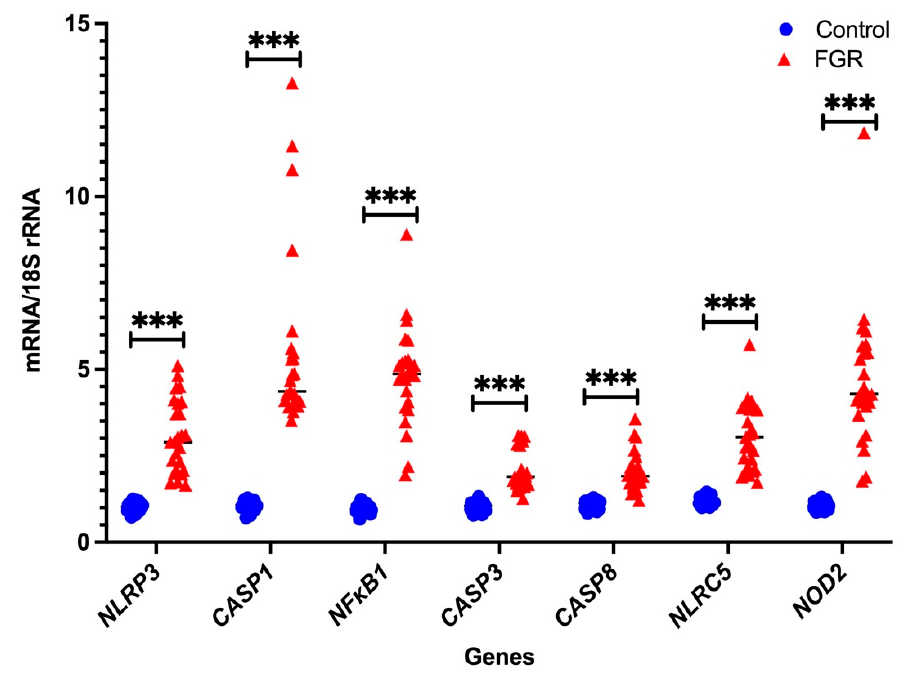
Figure 1. Real-time PCR validation of DAMPs: independent validation of DAMPs-involved mRNA gene expression relative to 18S rRNA . Statistical significance was determined using a Mann–Whitney U test and indicated by *** ( p <